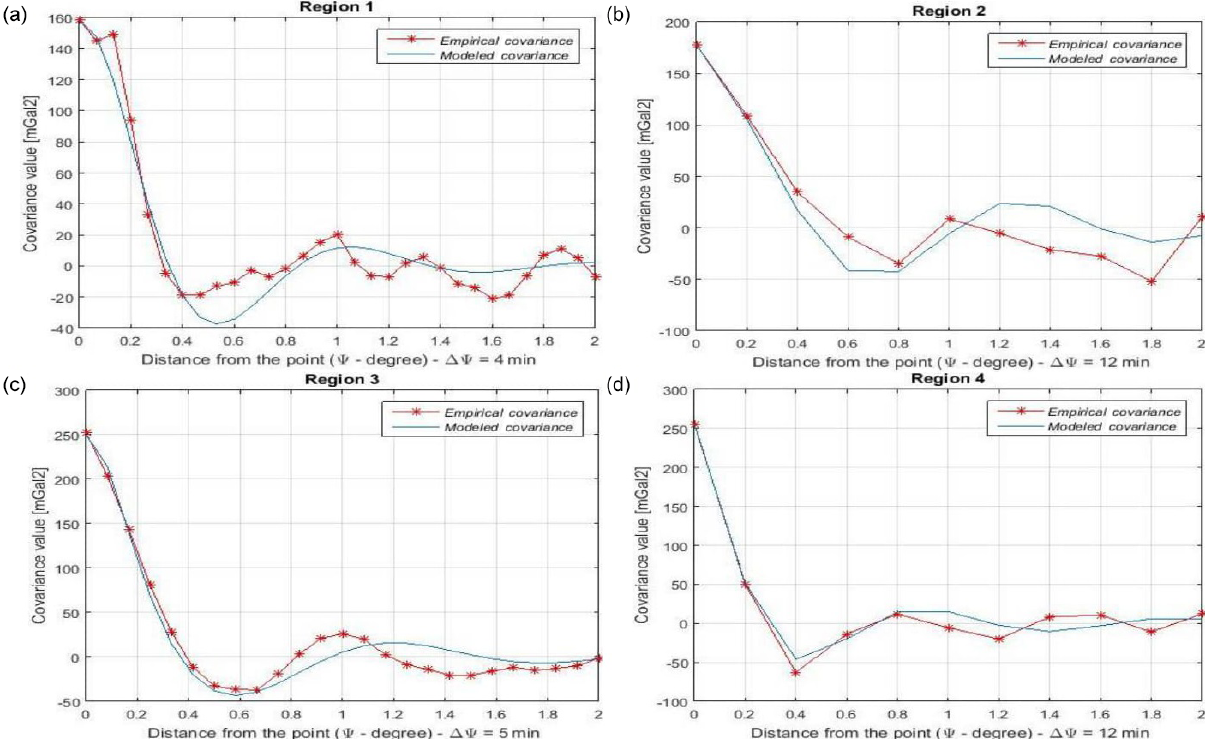
Figure 3. Empirical and fitted COV for residual gravity anomalies of the regions (a) R1, (b) R2, (c) R3 and (d) R4.